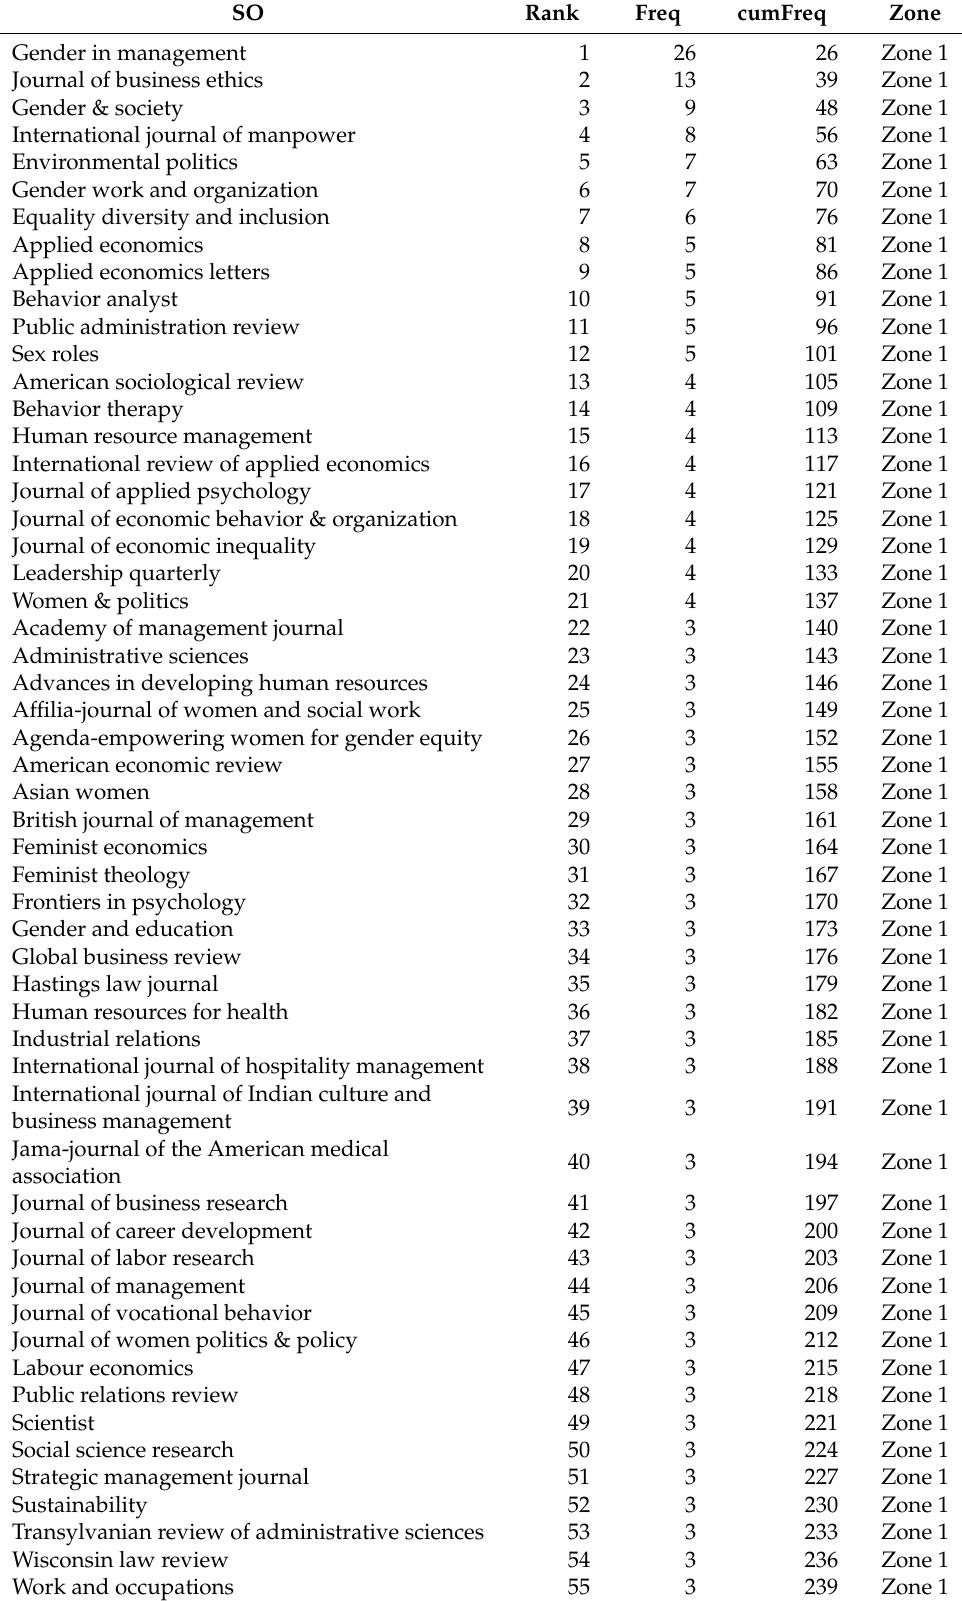
Table 2. Journals classification according to Bradford’s